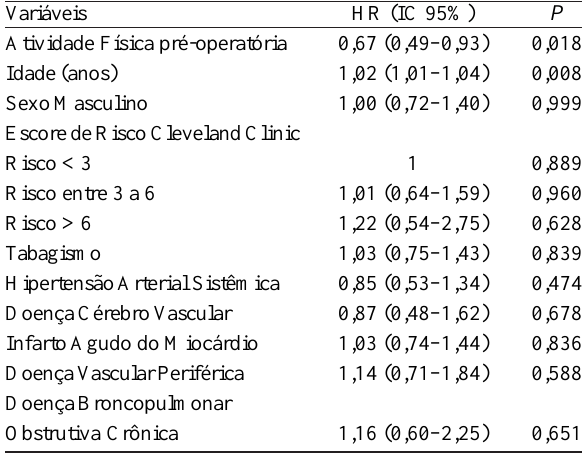
Figura 1 apresenta os resultados relativos ao efeito da AFiTL no resultado precoce da CRM, como demonstrado pela análise multivariada de regressão logística. Os